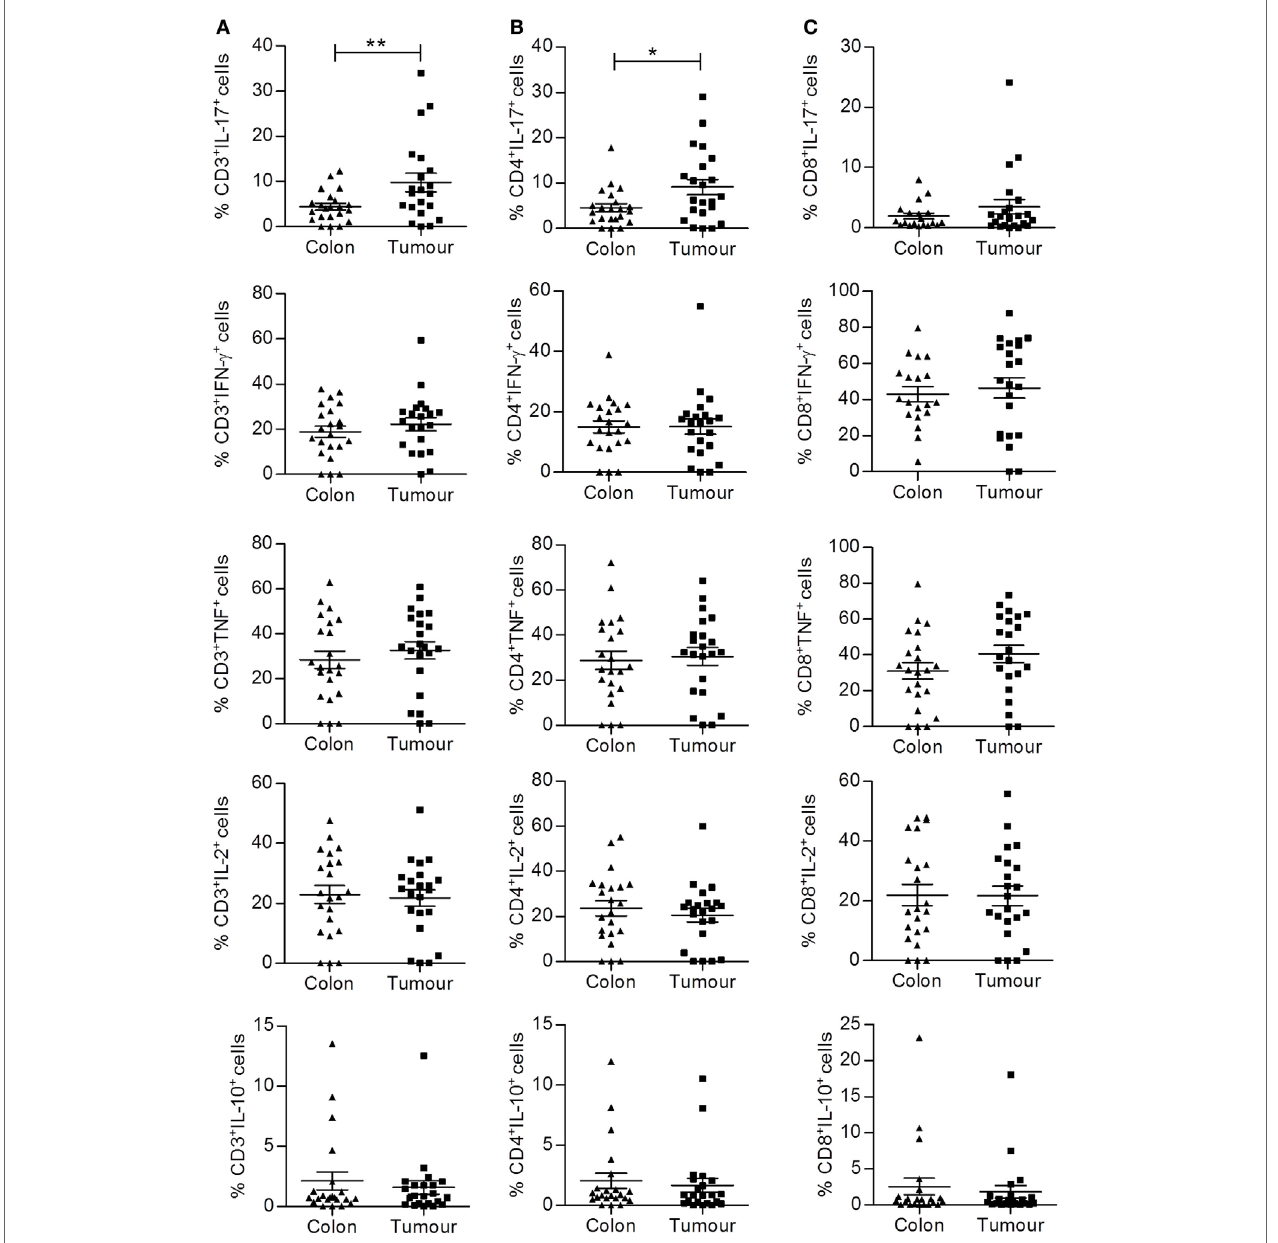
FigUre 2 | increased frequency of cD4 + il-17 + (Th17) cells infiltrating colorectal tumor tissue compared to normal adjacent tissue . Tumor tissue and adjacent uninvolved colonic tissue were enzymatically digested, and the resulting single cell suspension was stimulated with PMA and ionomycin. Cells were stained with antibodies specific for CD3 and CD8, permeabilized, and stained for intracellular expression of cytokines IFN- γ , IL-17, TNF, IL-2, and IL-10. The frequency of cytokine expressing total CD3 + (a) , CD4 + (CD3 + CD8 − ) (B) , or CD8 + (c) T cells is shown for uninvolved colon and colorectal tumor tissue. * p < 0.05, ** p < 0.01 as determined by Wilcoxon signed rank